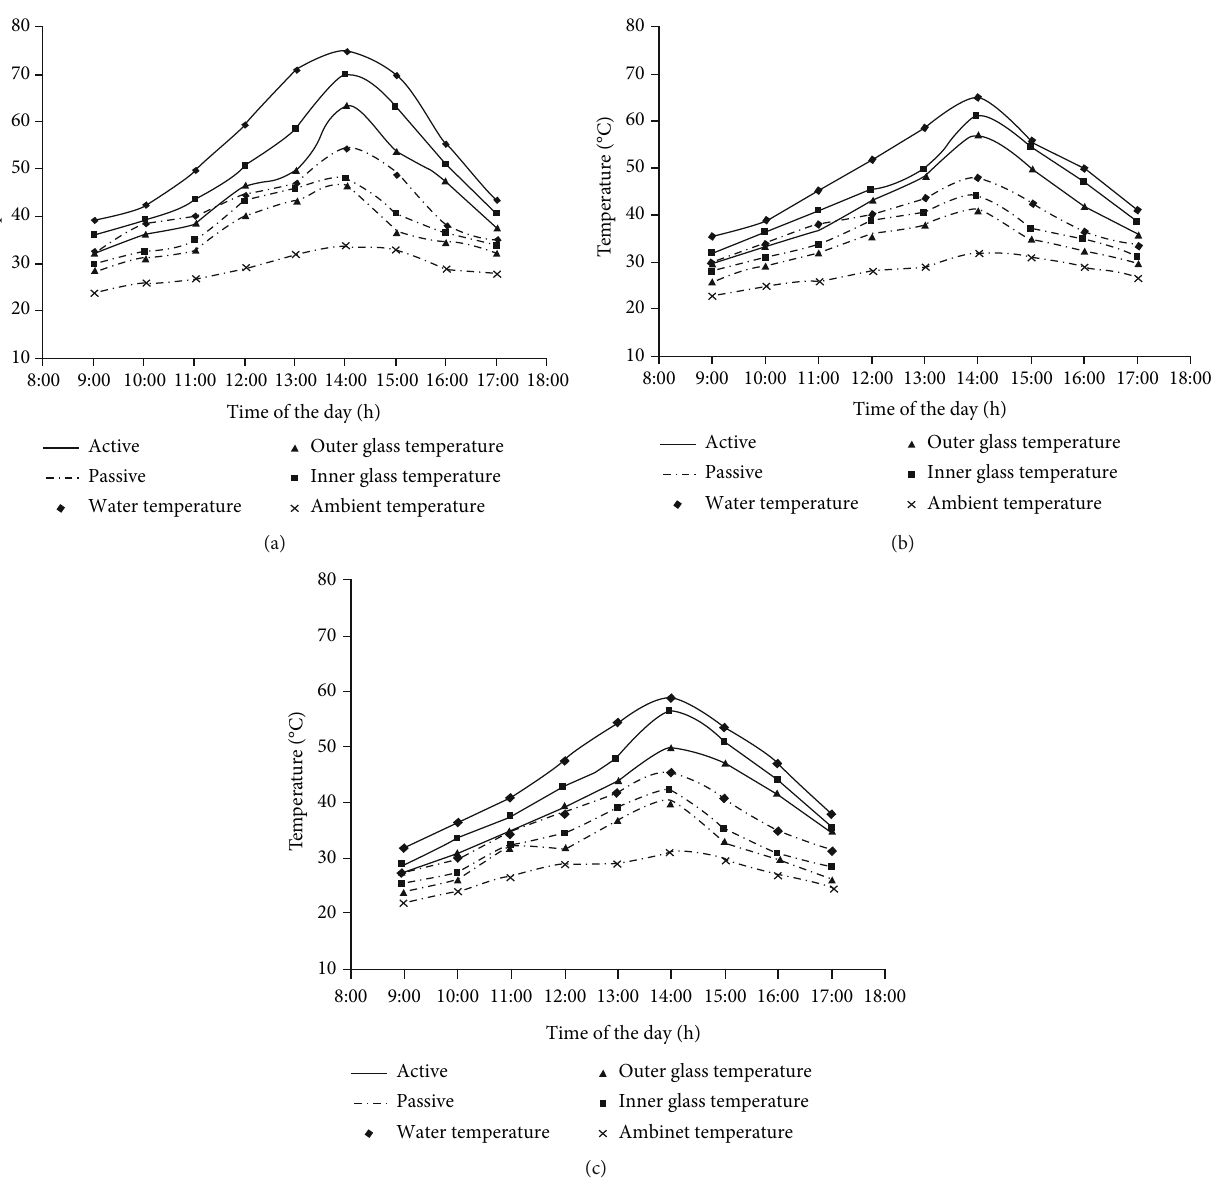
Figure 6: Glass cover thickness e ff ect on the temperature measurement, (a) 3mm thickness, (b) 4 mm thickness, and (c) 5mm thickness